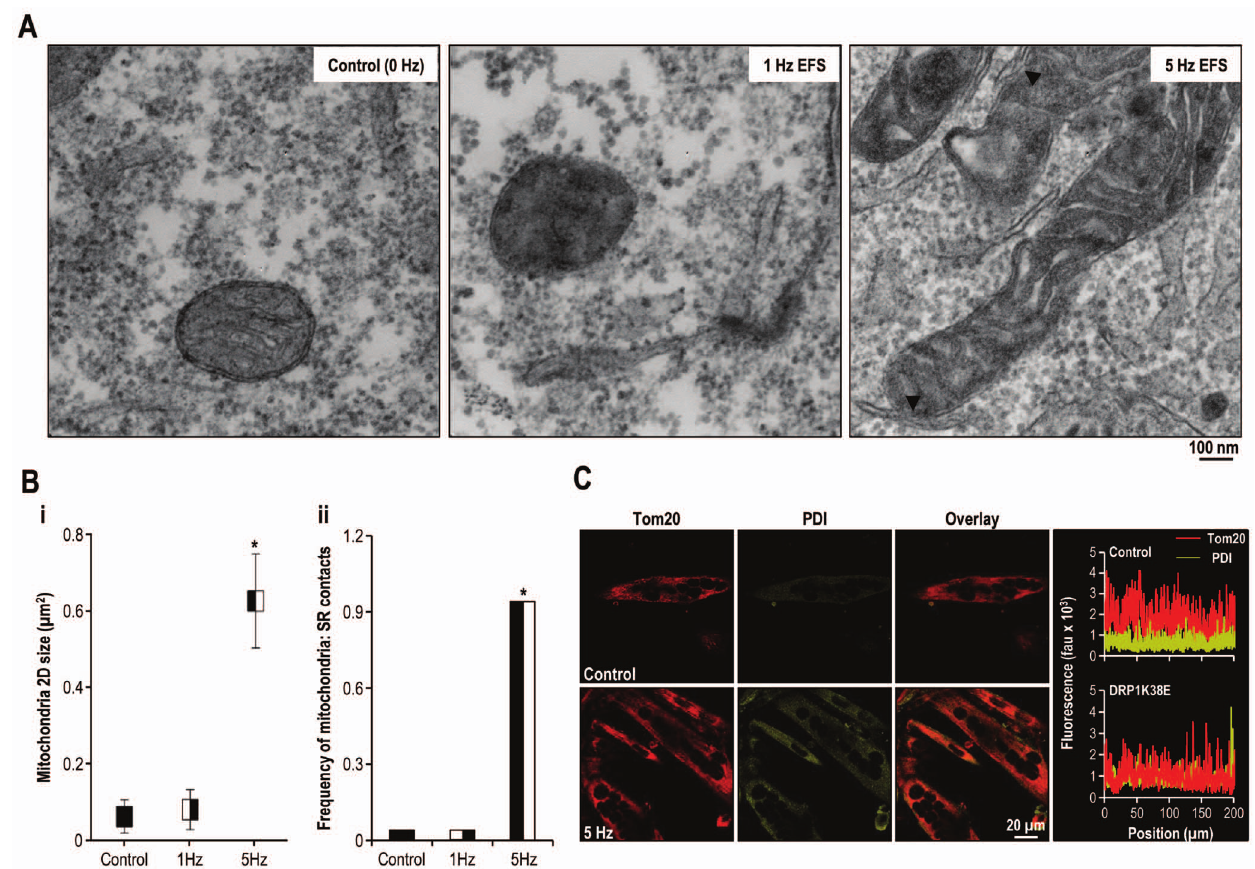
Figure 2. Rapid stimulation promotes mitochondrial fusion, SR colocalisation and increased frequency of SR: mitochondrial contact sites. C2C12 myocytes were induced to differentiate for 72 h, and then were left unstimulated (control) or were subjected to EFS at a frequency of 0 Hz, 1 Hz or 5 Hz for 24 h. Panel A: Representative electron micrographs (x25000) of differentiated C2C12 myotubes following 0 Hz (control), 1 Hz or 5 Hz field stimulation. Arrowheads mark mitochondria-SR contact sites. Panel B: Objective mean quantitative data for ( i ) mitochondrial 2D area and ( ii ) the occurrence of visible MAM on 2-D electron microscopy. ( i ) Mitochondria 2D size is length multiplied by width. ( ii ) Frequency of mitochondria-SR contact sites is the ratio of the number of mitochondria-SR contacts to the number of mitochondria. Panel C: Confocal images of Tom20 and PDI distribution in electric field stimulated C2C12 myotubes. To illustrate colocalisation of mitochondria and ER markers, the corresponding line scans of Tom20 and PDI are drawn on the right. # Denotes p , 0.001 Fisher ’ s exact test and one-way ANOVA, n=50 all